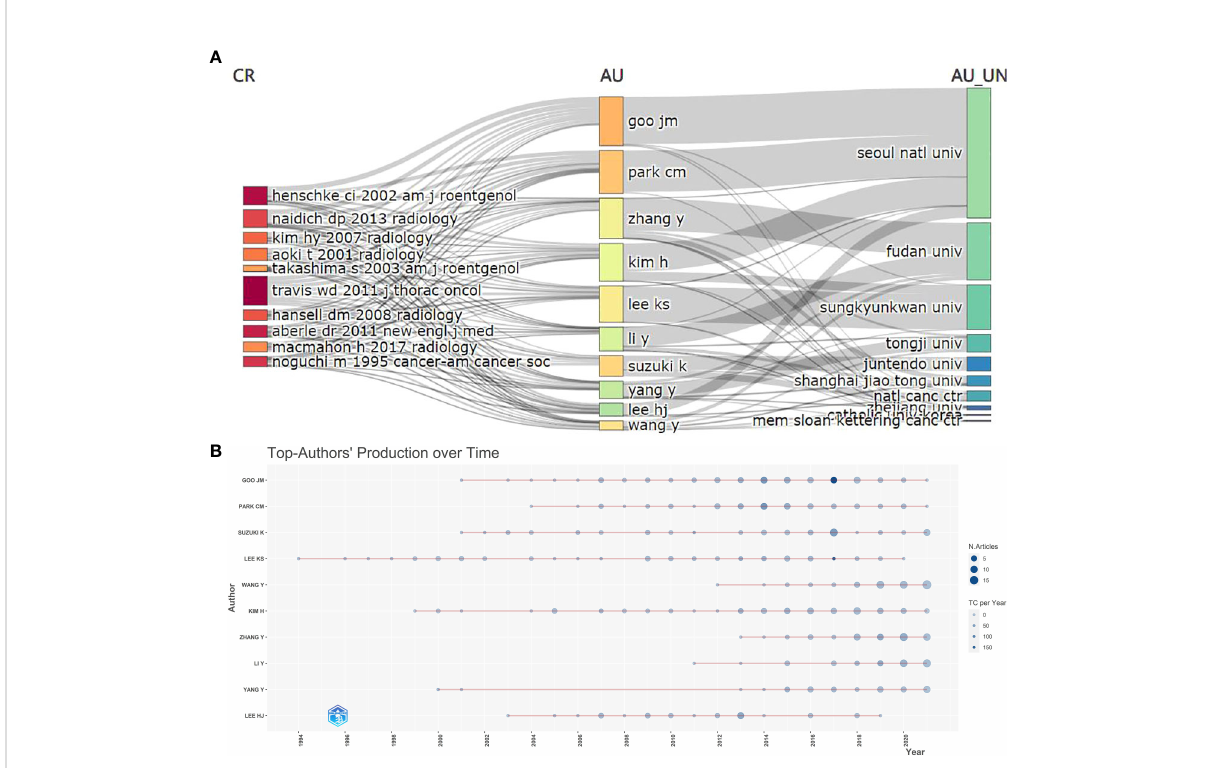
FIGURE 3 (A) The top 10 most published authors. CR: Source Journal. AU: Author. AU-UN: Author University. (B) Top-authors ’ production over